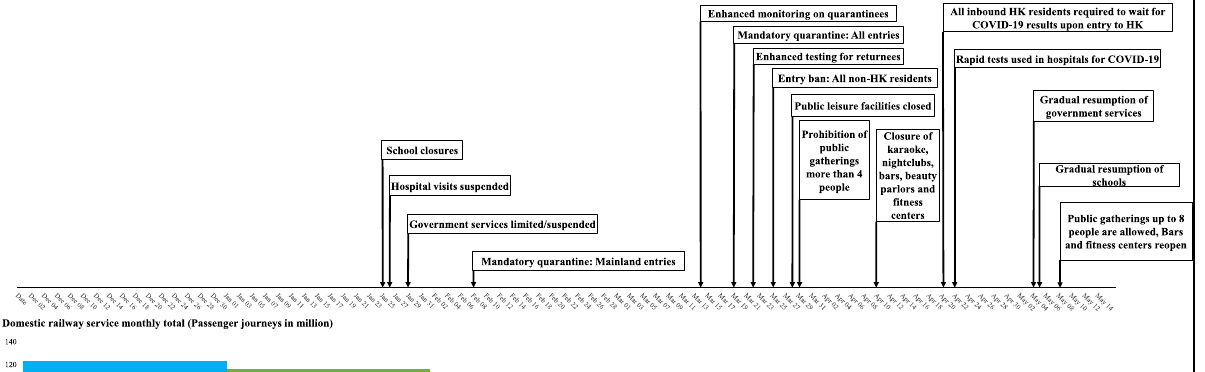
inversely correlated with self-rated physical and mental health in different populations 21 . Alphas were 0.93 in both administrations.